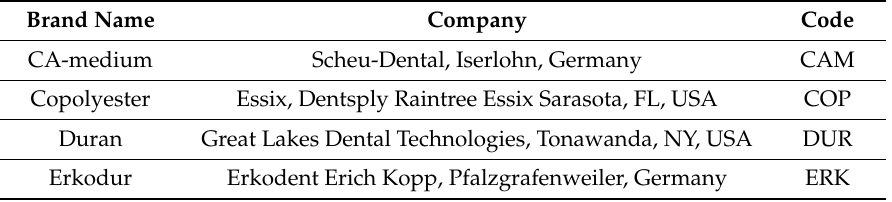
Table 1. Brand names manufacturers, and codes for all materials